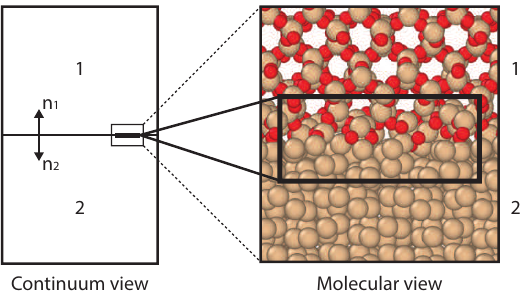
Figure 1. A schematic representation of continuum and molecular view of a system chosen for the present